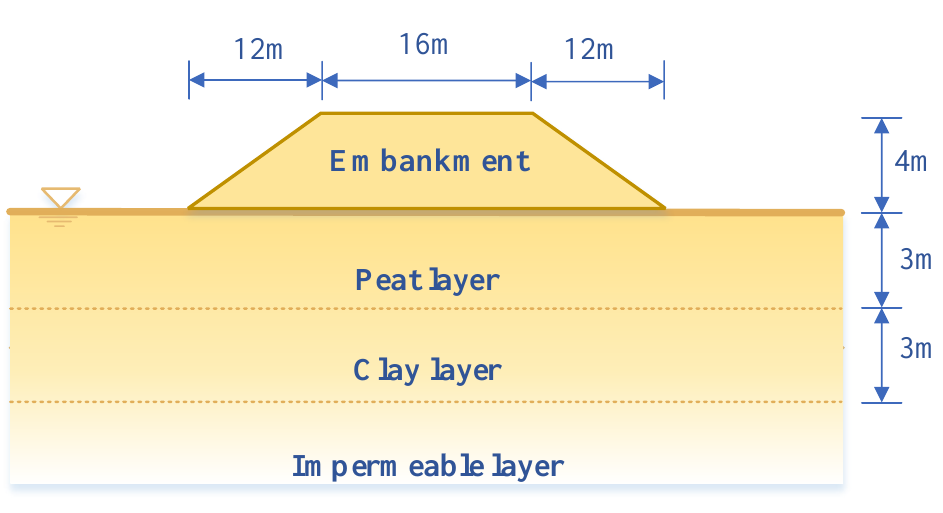
Figure 14. Schematic diagram of geological section of the